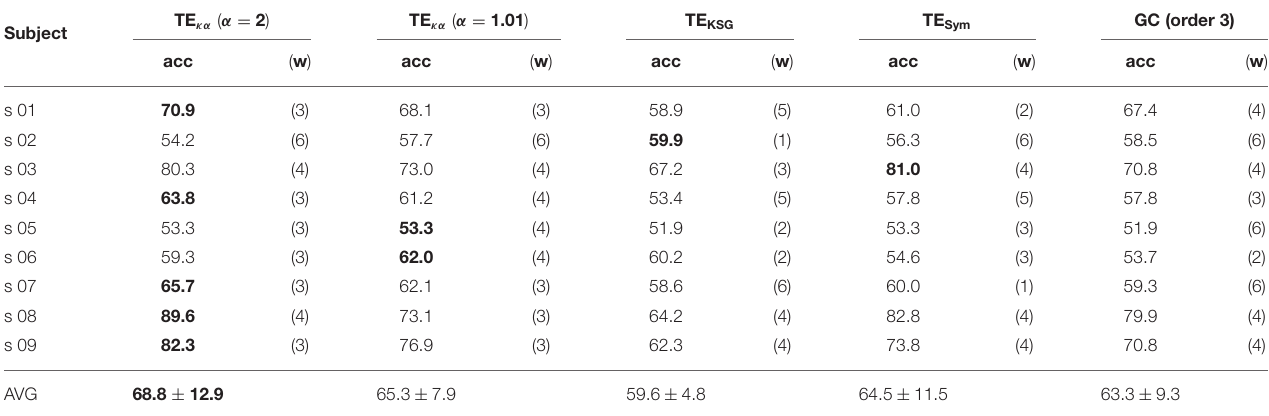
TABLE 2 | Testing accuracy [%] for the window ( w ) with the best